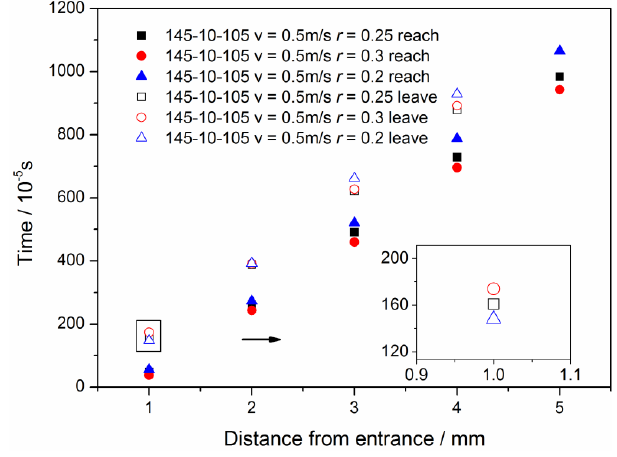
Figure 17. Comparison of time consumed with different initial radius of the water droplet.